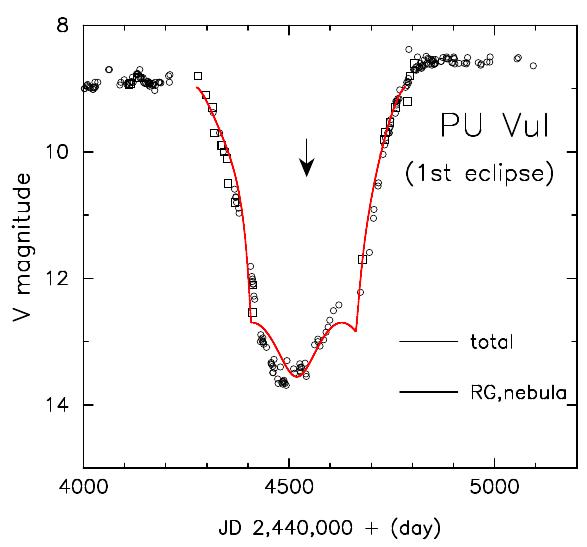
Fig. 4. A close-up view of the first eclipse. Optical data are the same as in Kato et al. (2011). The red solid line indicates the eclipse light curve model in which the WD is occulted by the pulsating RG with amplitude of 75 % around its equilibrium luminosity corresponding to m V = 13 : 8. We also assume the additional nebular component of m V = 13 : 8. The total mean magnitude of the bottom of the eclipse is m V = 13 : 0. The downward arrow indicates the date of mid-eclipse, JD 2 444 532. See text for more